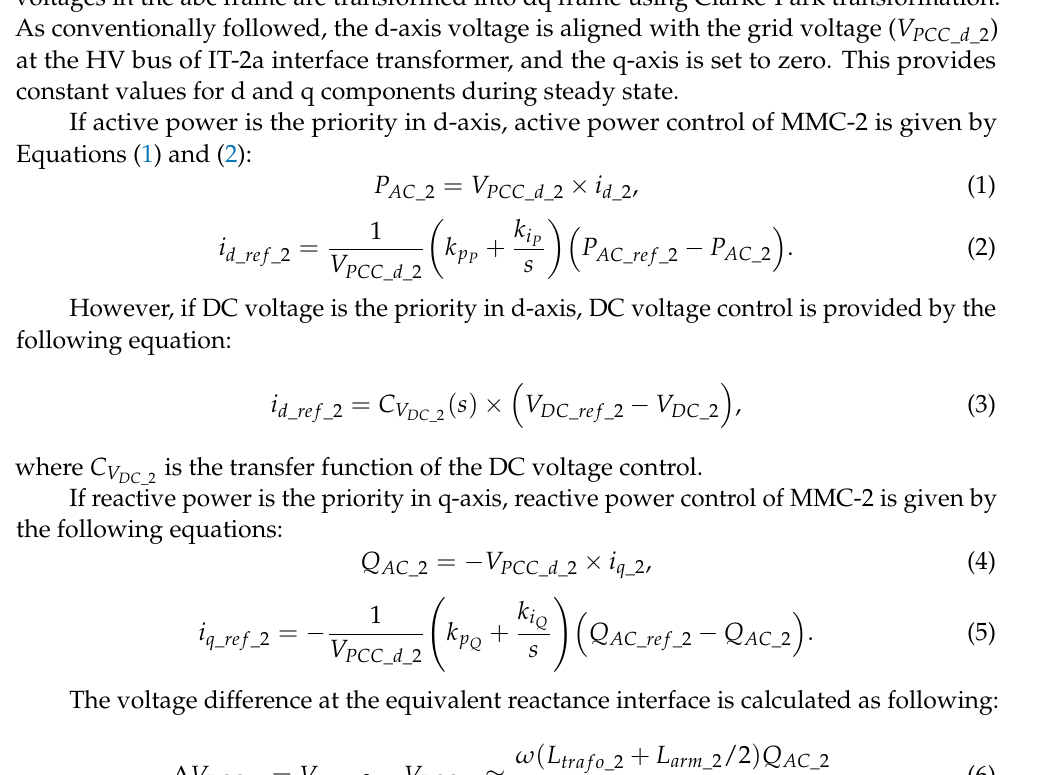
Figure 8. Simplified structure of the outer loop control for MMC-2. ( a ) Outer control loop representa- tion for d-axis ( i d _ ref _2 ); ( b ) Outer control loop representation for q-axis ( i q _ ref _2 ). The parameters defined in this section are mathematically derived in [23]. The rotating dq frame provides a simplified control for the three-phase systems. The currents and voltages in the abc frame are transformed into dq frame using Clarke-Park